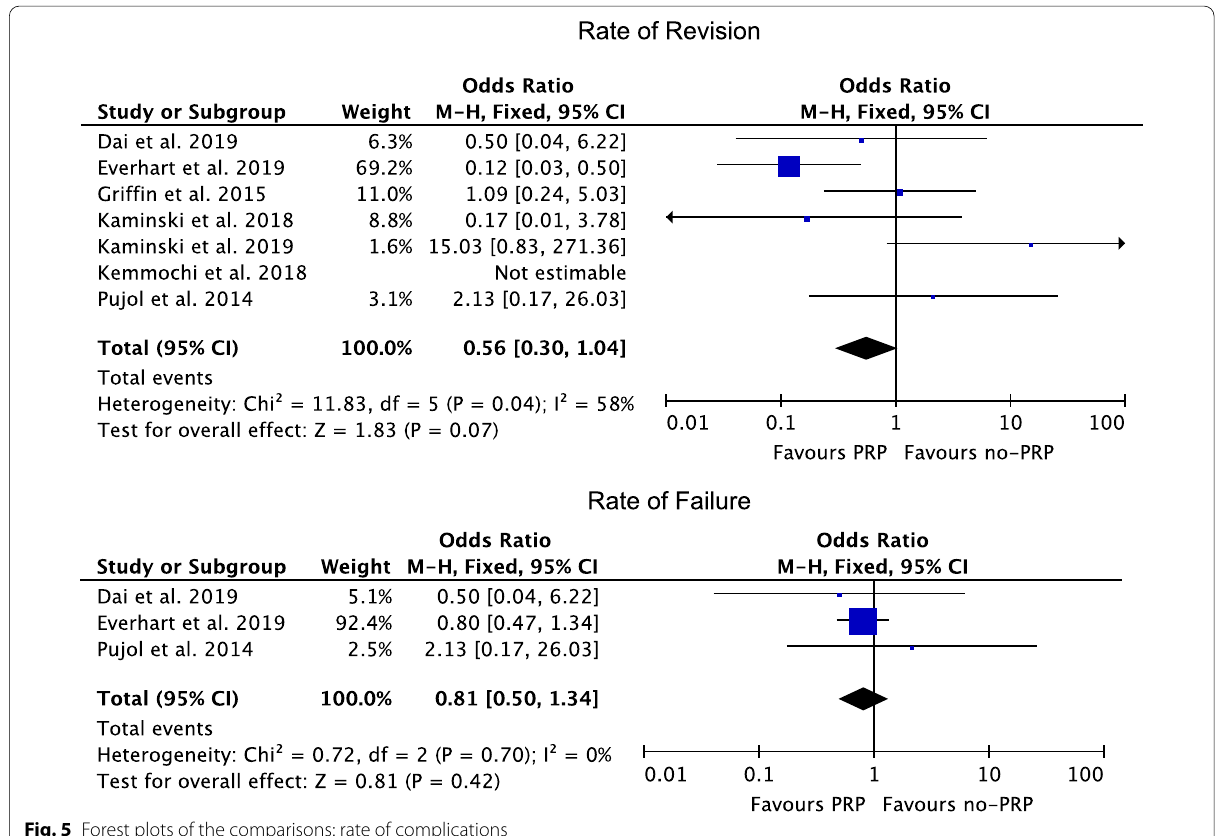
Fig. 5 Forest plots of the comparisons: rate of